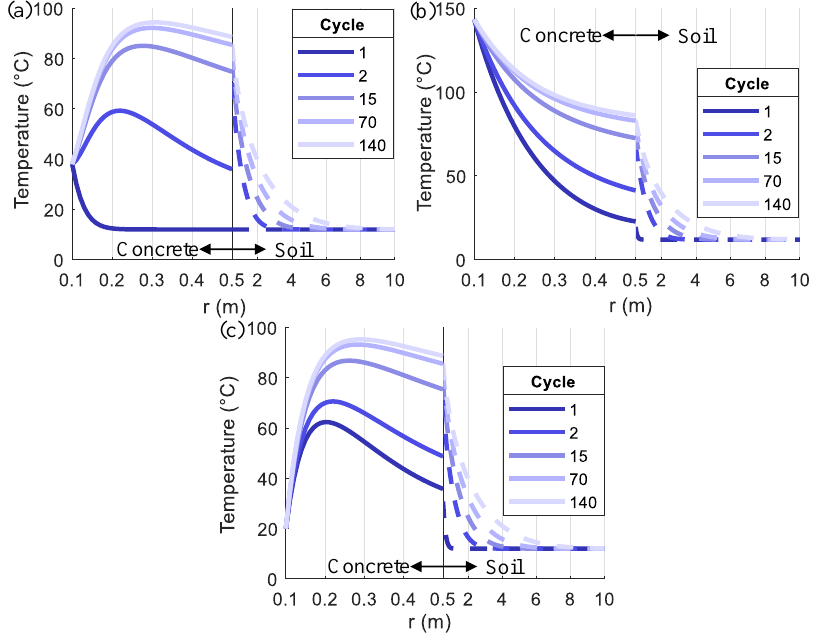
Figure 12. Temperature distribution in different loading cycles at: ( a ) 7:20; ( b ) 19:00; ( c ) 7:00.